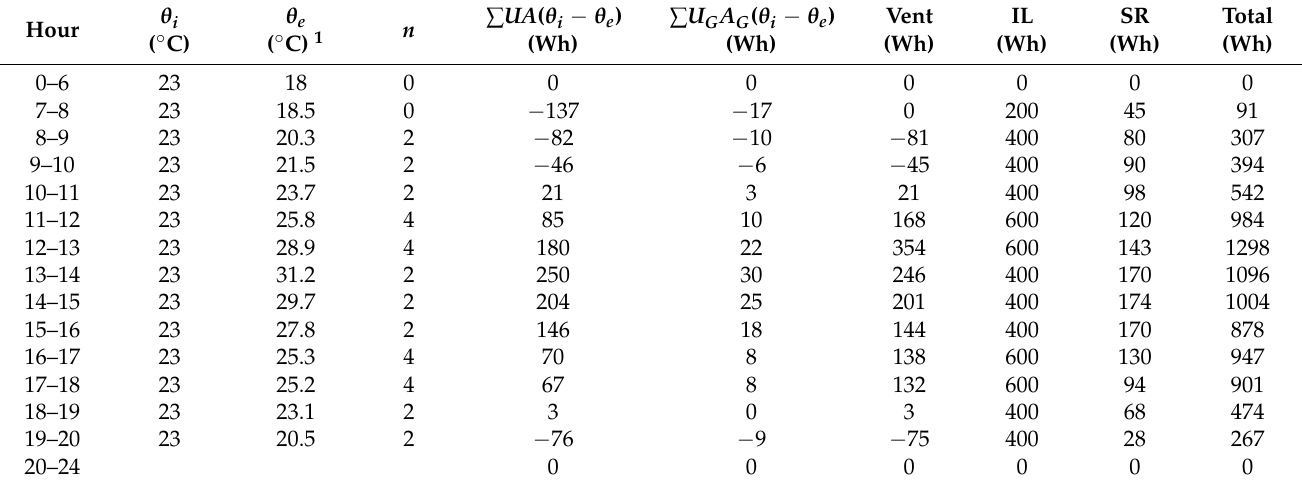
Table 3. Summer cooling loads on 2 July